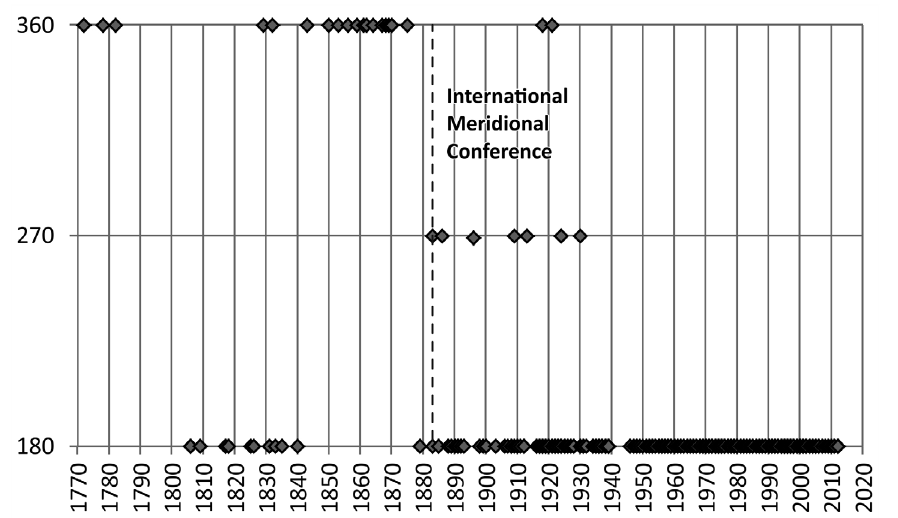
Fig. 5. The editions of the Polish school atlases according to the applied system of determining the longitude. 180° + 360° category applies only to the W. Hardt’s atlas for the folk schools (eight editions and circulations